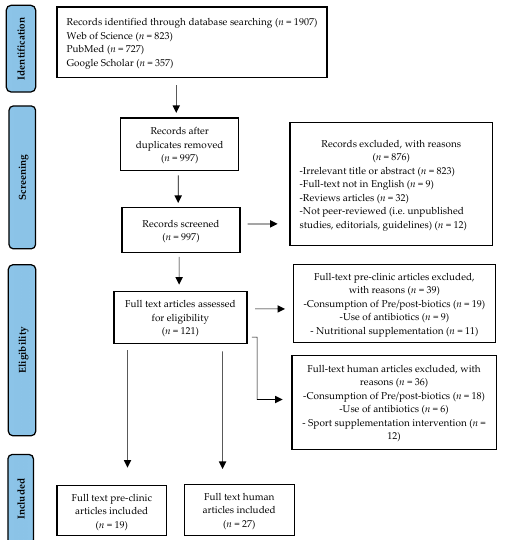
Figure 1. Study selection and eligibility screening flow diagram.